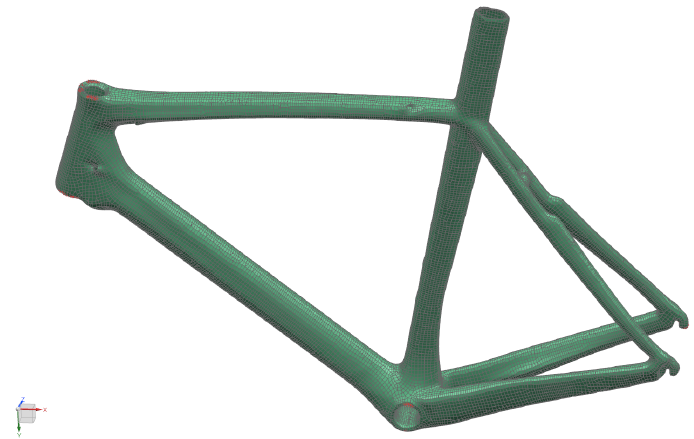
Figure 3. Overview of the 2D mesh of the bicycle